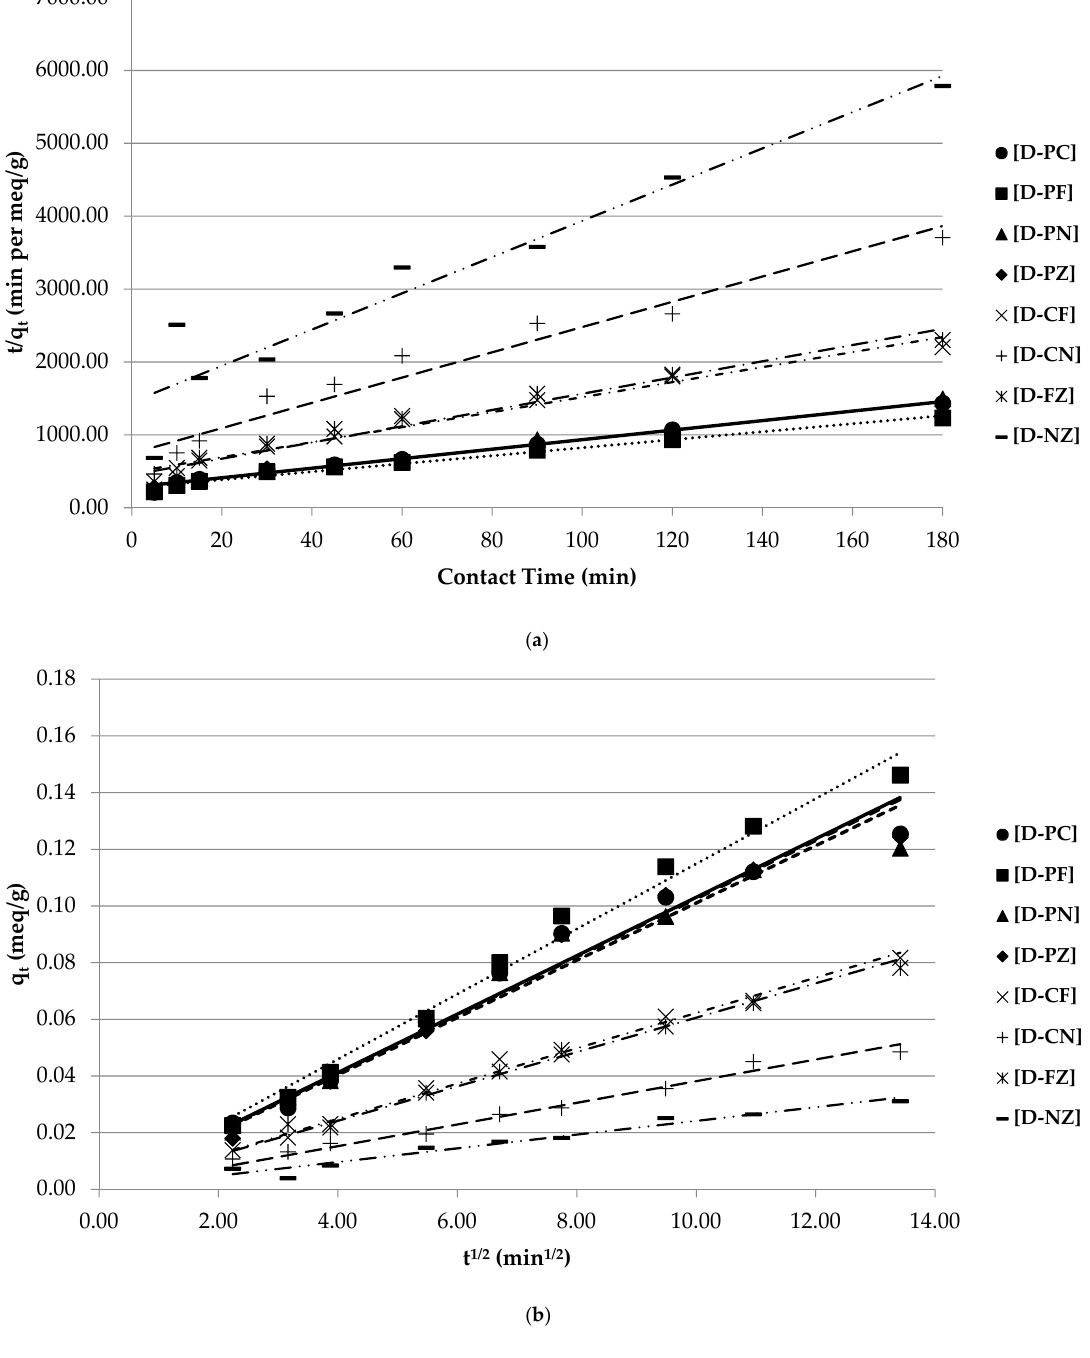
Figure 3. Dual ‐ component system kinetic model plots: ( a ) pseudo ‐ second ‐ order; ( b ) intra ‐ particle diffusion.